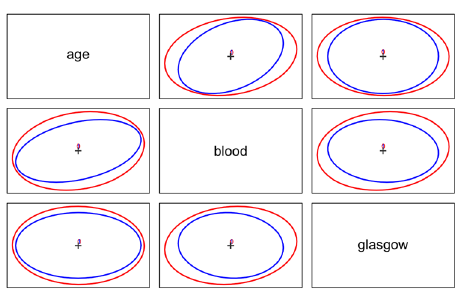
Figure A4: Pairwise data ellipses for the CRASH - 3 and Traumabase data , centered at the origin. CRASH - 3 data are in blue and Traumabase data in red. This view allows to compare the variances and covariances for all pairs of variables. While the mean are really di ff erent in the two sources, the variances and covariances are not so di ff